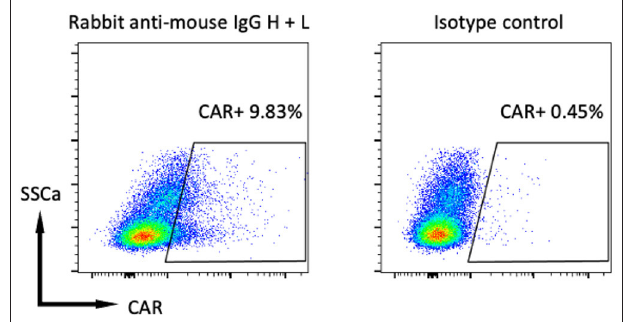
FIGURE 1 | Flow cytometry of cells isolated from fine needle aspiration of the patient’s left prescapular lymph node and stained for CD5-PE, CD79a-APC and CD20-BV421 as previously described (6).